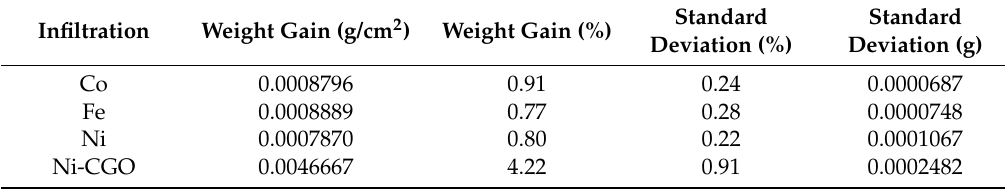
Table 1. Average weight gain and weight gain percentage after